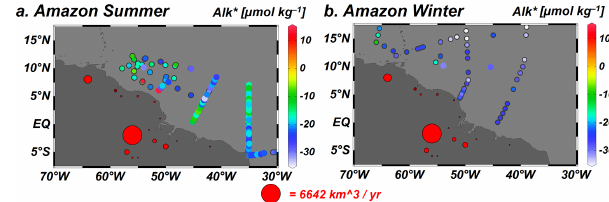
Figure 7. Alk ∗ (in µmolkg − 1 ) in top 50m of the ocean near the Amazon River outflow plotted in color, though with a narrower color scale than is used for all other plots. Panel (a) is limited to data collected in November through January, and panel (b) is limited to measurements from May through July. Points with black borders indicate either that the AT was measured prior to 1992 (before ref- erence materials were commonly used) or that no nitrate value was reported (in which case a nitrate concentration of 5µmolkg − 1 is assumed). Red dots on land indicate the mouth locations and mean annual discharge volumes (indicated by dot size) of large rivers, as given by Dai and Trenberth